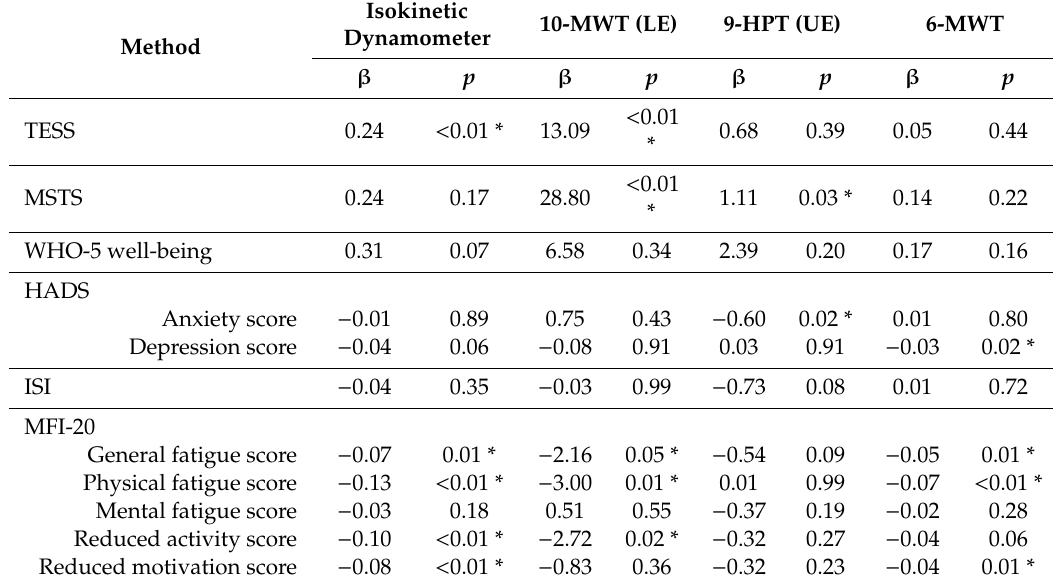
Table 6. Linear regression analysis of objective measures’ correlation to questionnaires, where questionnaires’ outcome is a dependent variable and objective tests are an independent